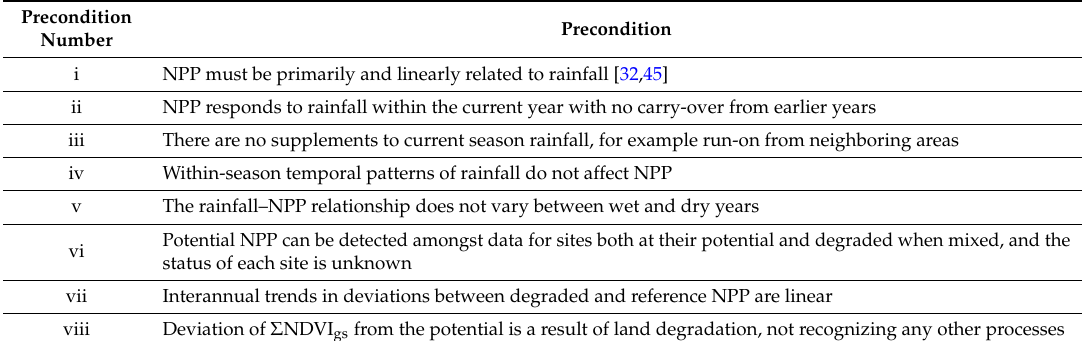
Preconditions for valid application of Rain Use Efficiency (RUE) for detection of dryland